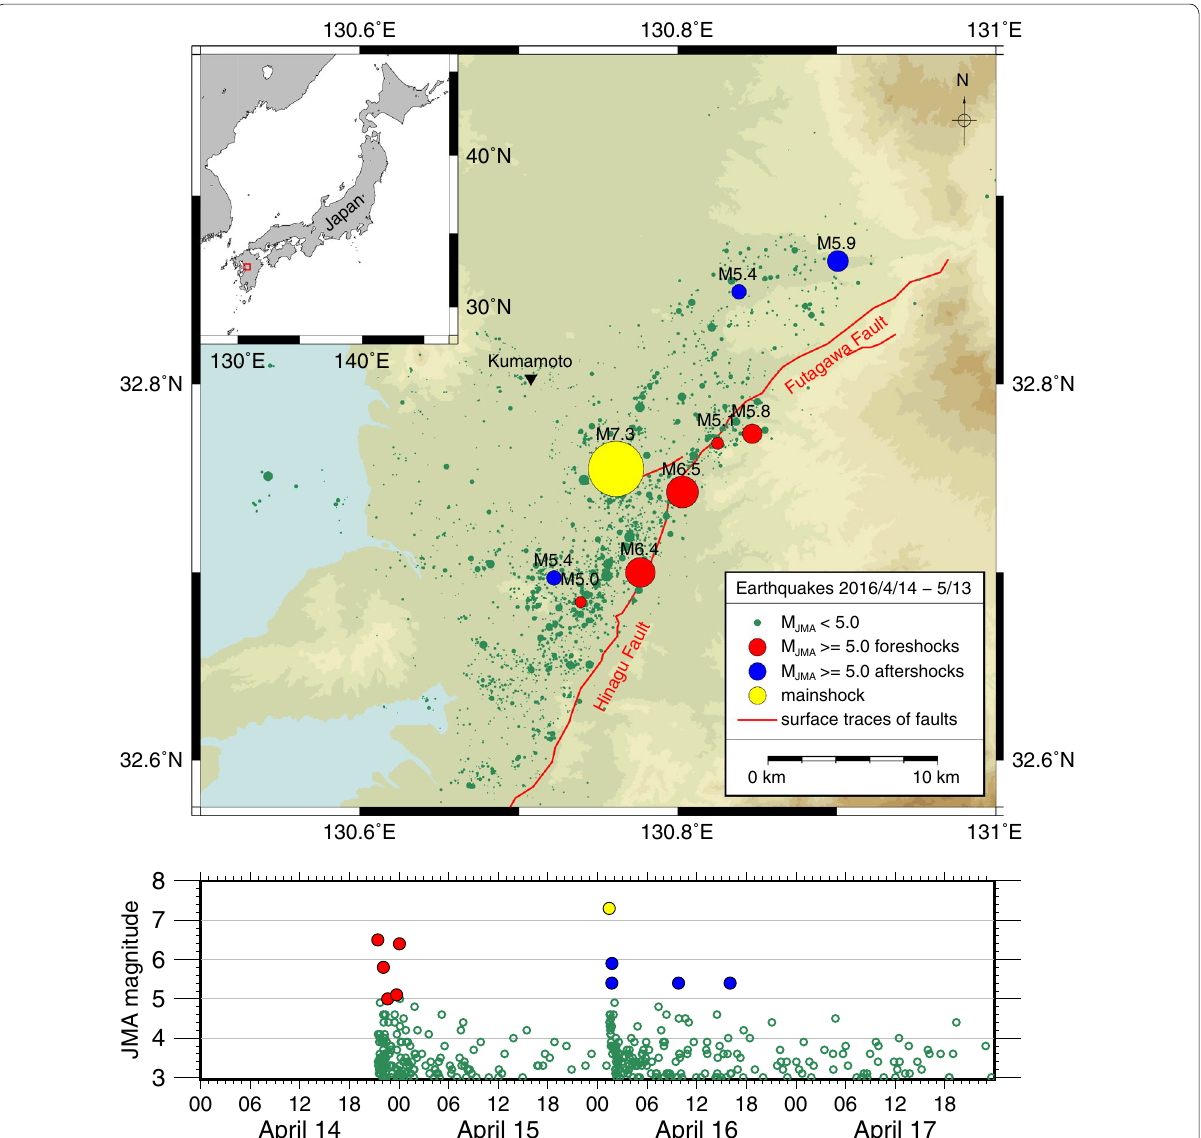
Fig. 1 Spatial and temporal distribution of the Kumamoto earthquake sequence; top panel—map of earthquake’s locations inferred by Kato et al. (2016) for period April 14–May 13, 2016. The size of circles is proportional to the JMA magnitude of the events. Earthquakes with M JMA magnitude higher than or equal to 5 are distinguish by color: foreshocks (red), mainshock (yellow) and aftershocks (blue); bottom panel—temporal evolution of the earthquakes from the map in top panel is showing period from April 14–April 17, 2016, when all events with M JMA magnitude higher than or equal to 5